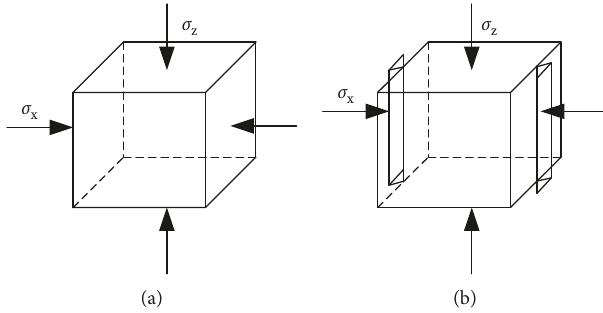
Figure 2: Biaxial loading schematic. (a) Biaxial compression-compression. (b) Biaxial compression-tension.